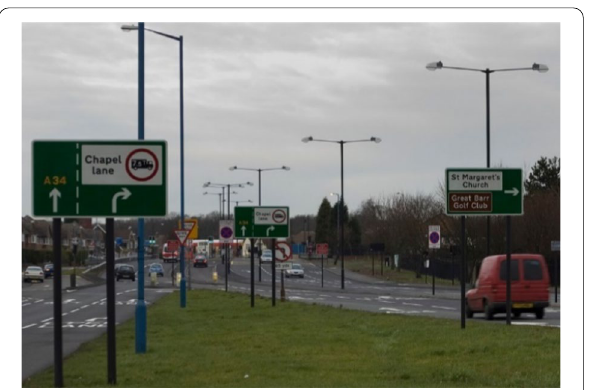
Fig. 3 An example of edge case related to multiple signs. An autonomous system may interpret all visible signs as relevant, even though some relate to a parallel road. "Furniture" by hartlandmartin is licensed with CC BY-NC-SA